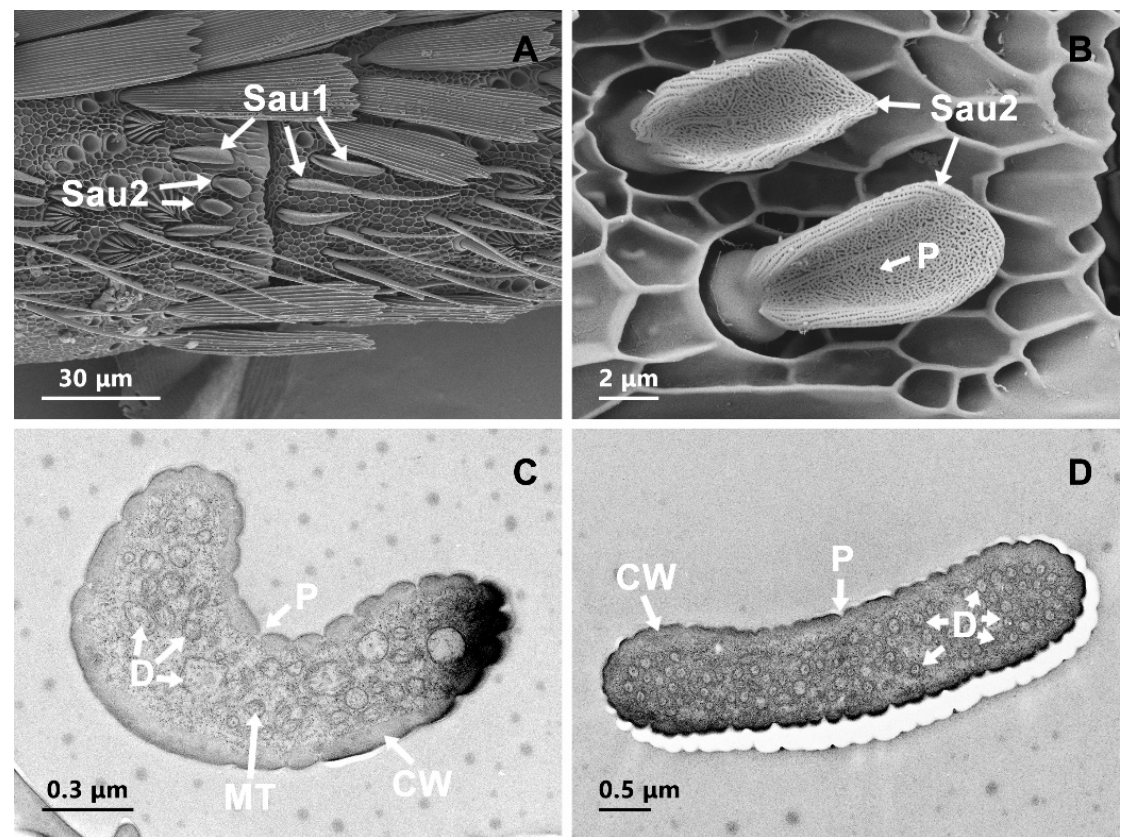
Figure 6. Scanning electron micrographs and transmission electron micrographs of sensilla auricillica 1 (Sau1) and sensilla auricillica 2 (Sau2). ( A ) Distribution pattern of Sau1 and Sau2; ( B ) the sur-